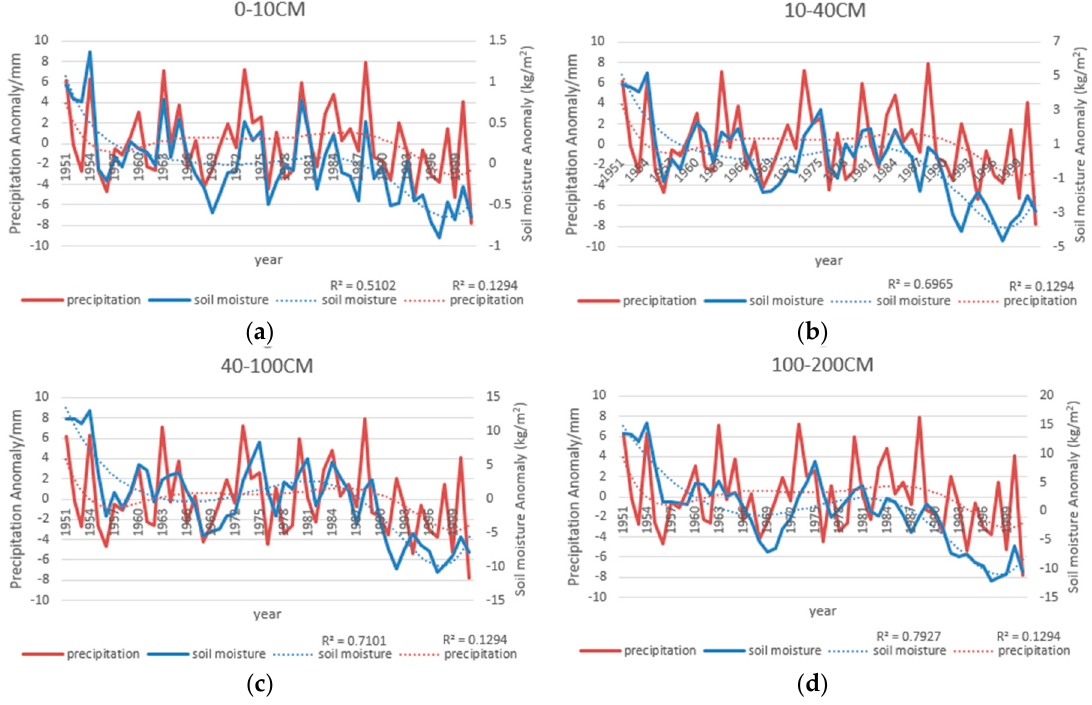
Figure 9. The relationship of annual average precipitation anomaly (red line) and the layers of soil moisture (blue line) from 1961 to 2011 in eastern China: ( a ) 0–10 cm; ( b ) 10–40 cm; ( c ) 40–100 cm; ( d ) 100–200 cm.